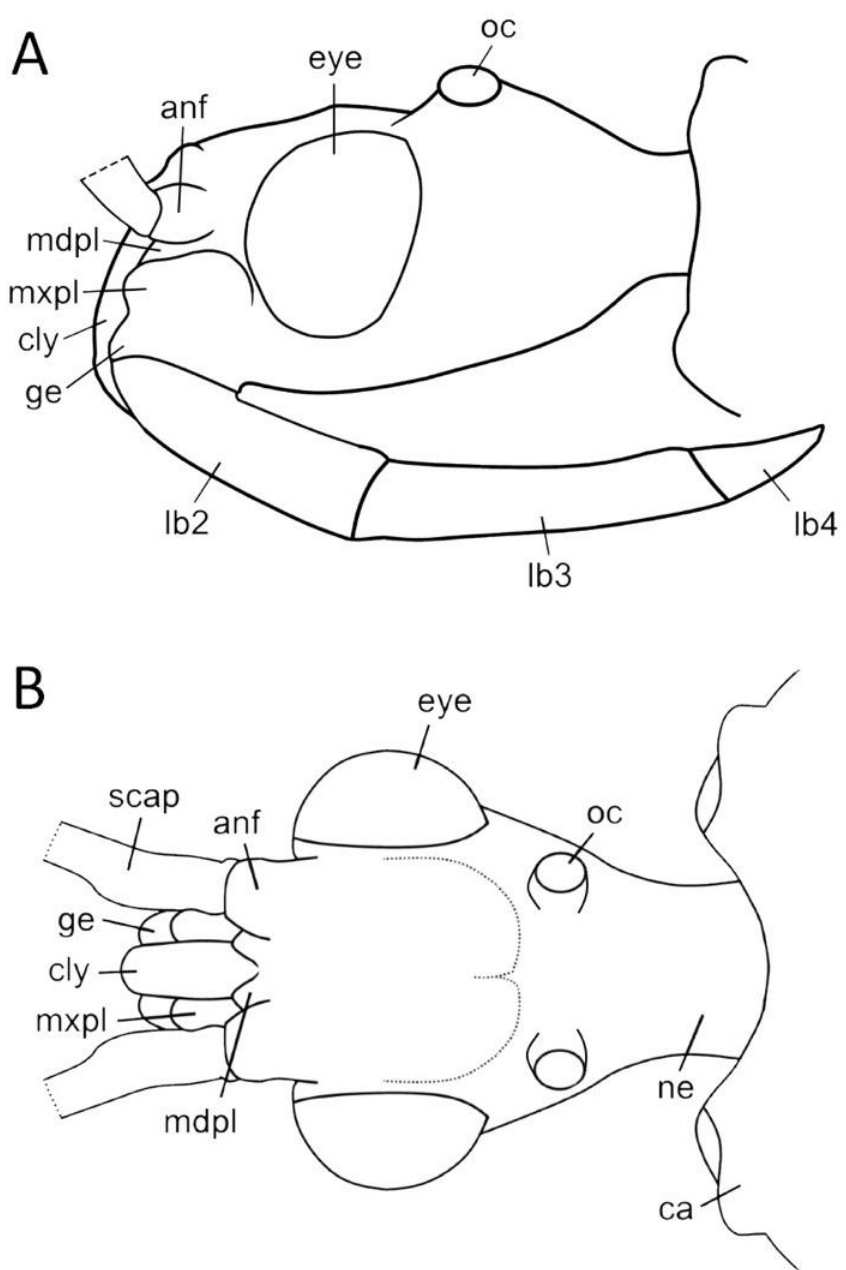
Figure 2. ( A ) Lateral and ( B ) dorsal view of general head morphology of Phonoctonus : anf — antennifer; ca — callus (pl. calli); cly — clypeus; ge — gena; lb2-4 — second to fourth labial segments; mdpl — mandibular plate; mxpl — maxillary plate; ne — neck; oc — ocellus (pl. ocelli); scap — scapus of the